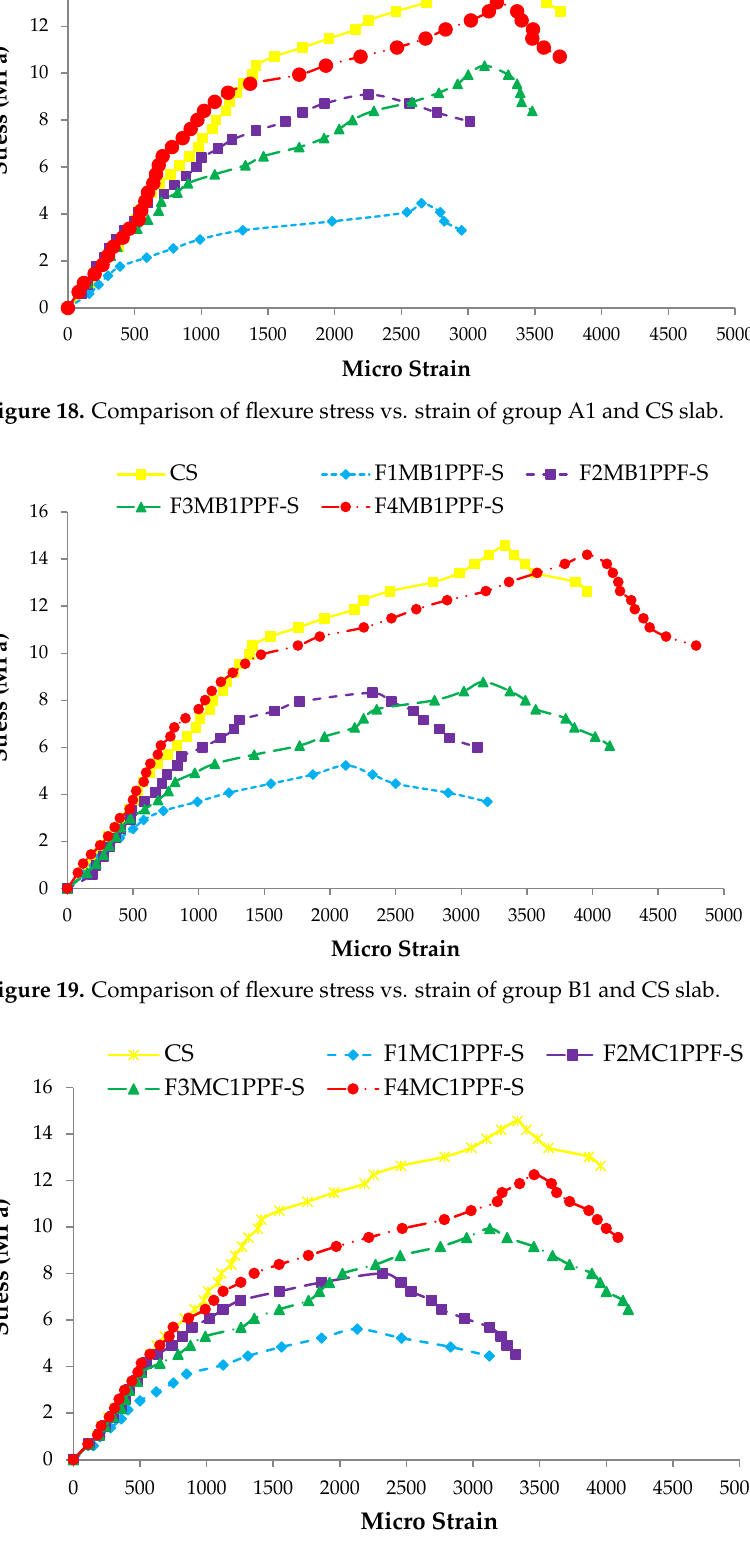
Figure 20. Comparison of flexure stress vs. strain of group C1 and CS slab.